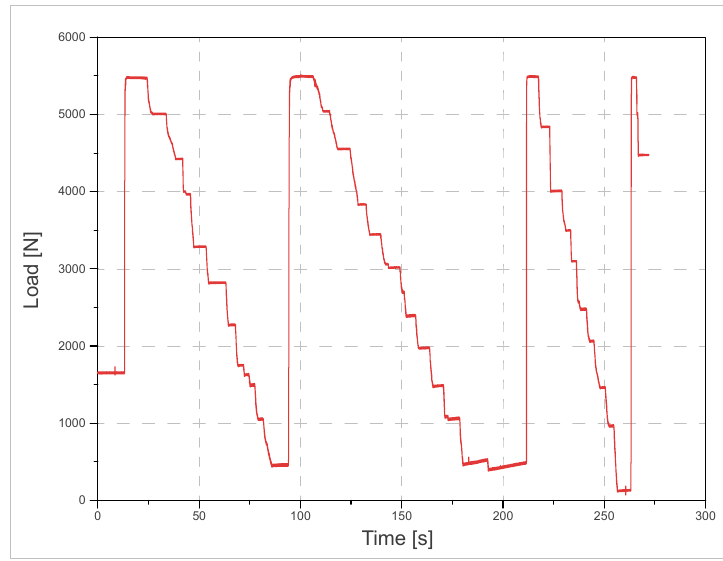
Figure 4. Load curve characteristics in the time domain.